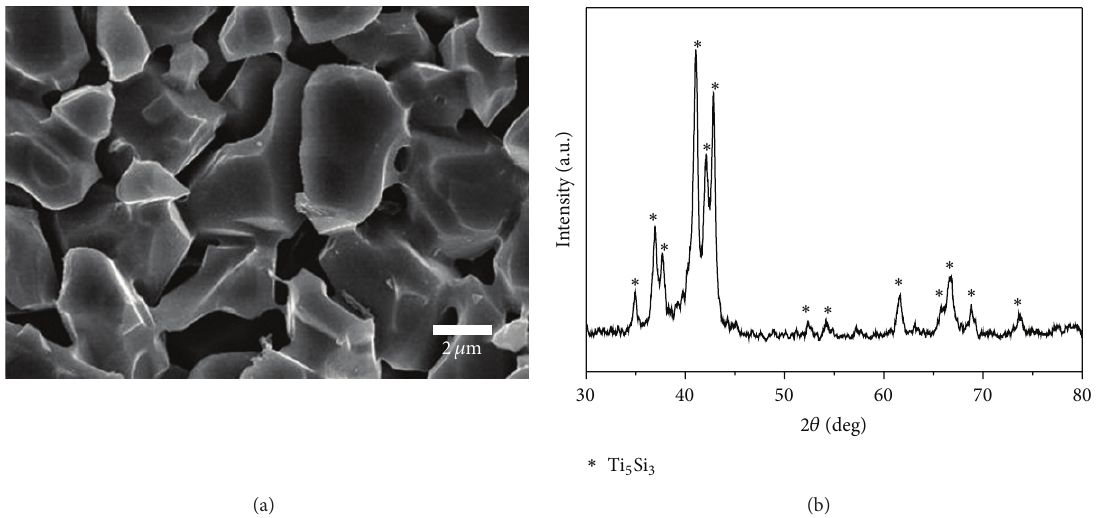
Figure 2: (a) SEM micrograph and (b) XRD patterns of MAed Ti-37.5 at.% Si powder mixture.